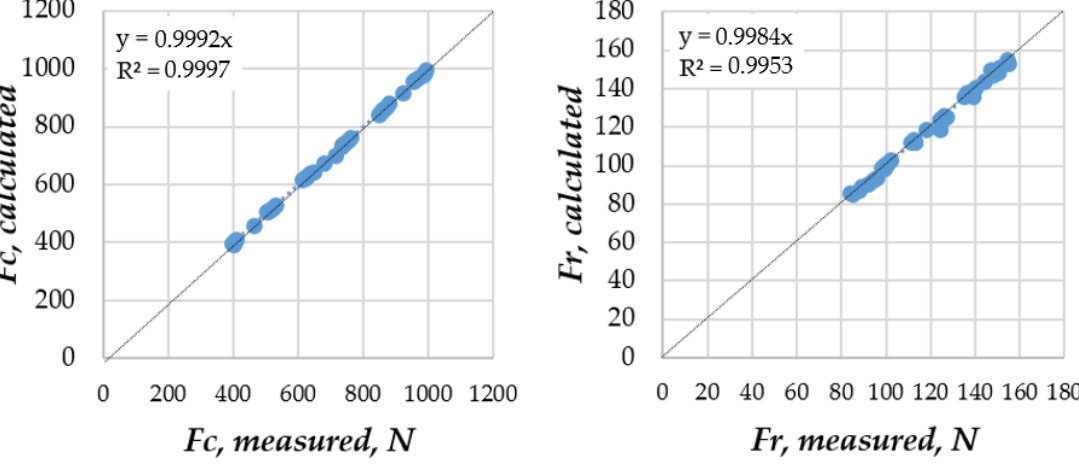
Figure 5. The calculated values as a function of measured values. In Figure 6 the residuals in a probability plot are shown. It is visible that the mean of the residuals is practically zero. The standard deviations of the residuals are very small (2.78 N for F c and 1.23 N for F r ), and in both components of force the residuals follow a normal distribution. Finally, it is concluded that expressions (25) and (26) are the appropriate models for the cutting